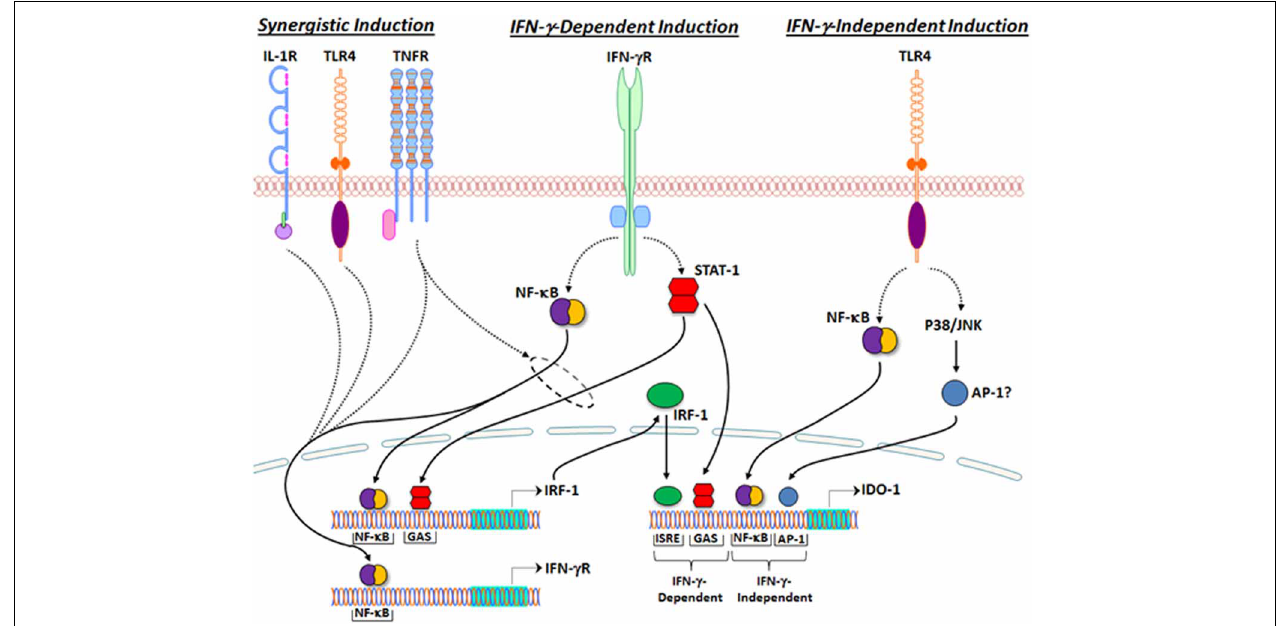
FIGURE 2 | Regulation of IDO1 transcription by inflammatory signaling. IFN- γ -dependent IDO1 induction ( middle ). Canonical IFN- γ receptor signal transduction leads to (1) NF- κ B- and STAT-1-dependent transcription of IRF-1, and (2) IRF-1- and STAT-1-dependent transcription of IDO1. Synergistic IDO1 induction( Left ).IL-1 β ,LPS,andTNF- α enhancetranscriptionofIFN- γ receptorin anNF- κ B-dependentmanner.TNF- α hasbeenshowntosynergisticallyenhance IFN- γ -dependent IDO1 transcription by promoting NF- κ B- and STAT-1-dependent IRF-1 transcription (within dashed circle). IFN- γ -Independent